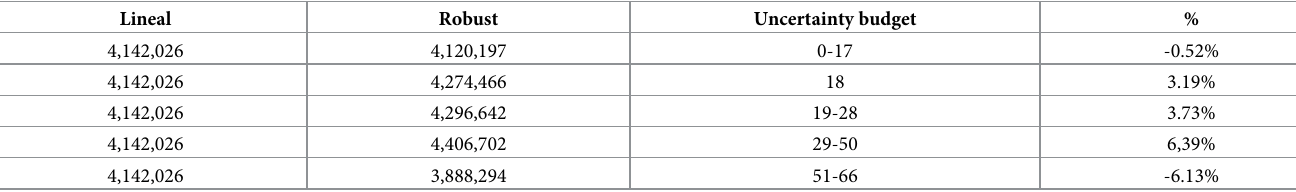
Table 13. Objective function value and its change under different levels of uncertainty. Lineal